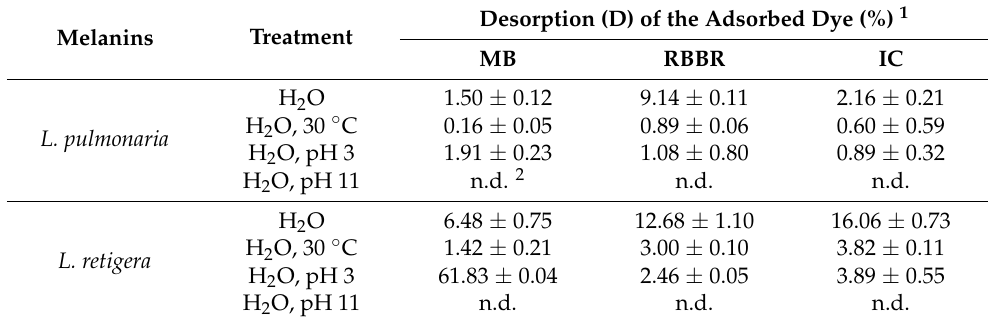
Table 4. Desorption of synthetic dyes adsorbed by melanins from L. pulmonaria and L. retigera .